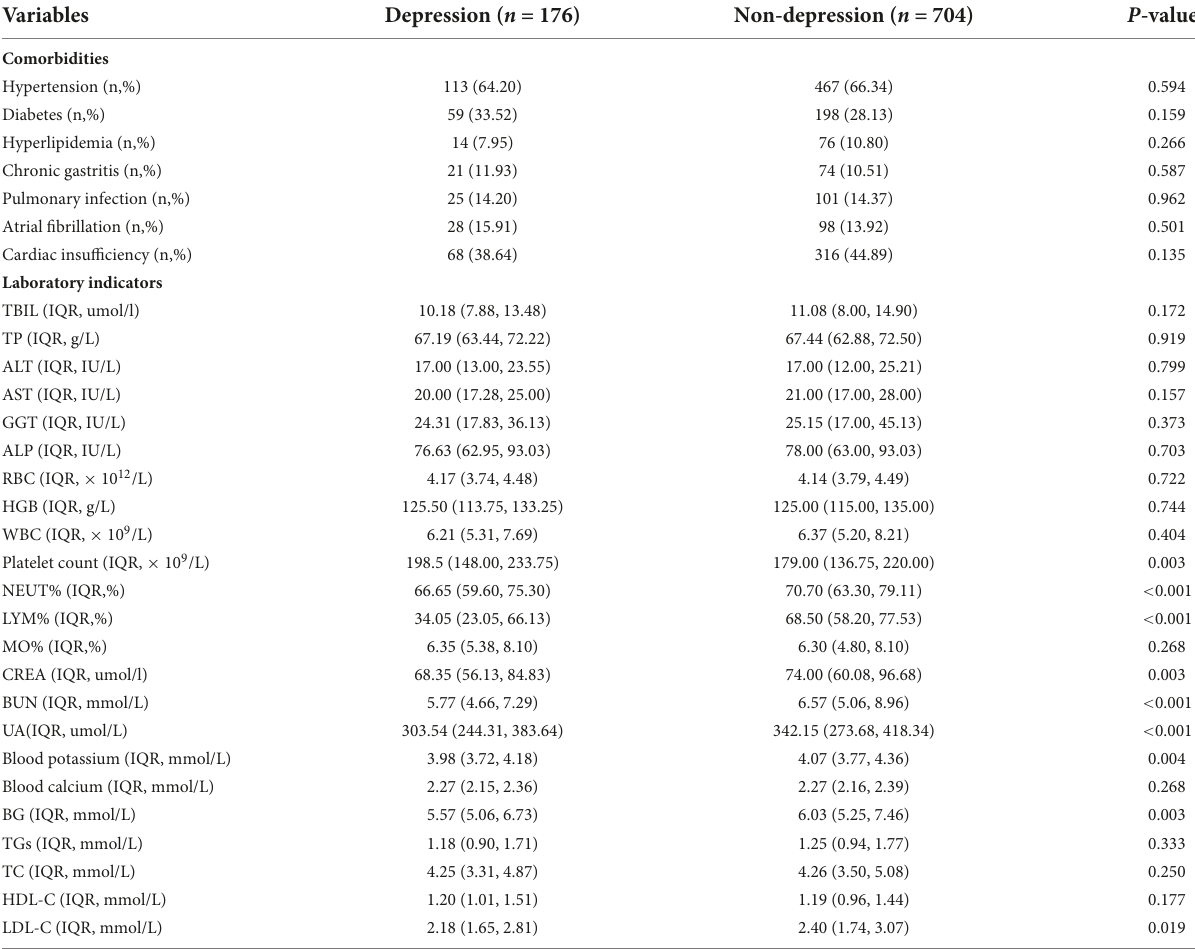
TABLE 3 Univariate analyses of variables associated with depression.